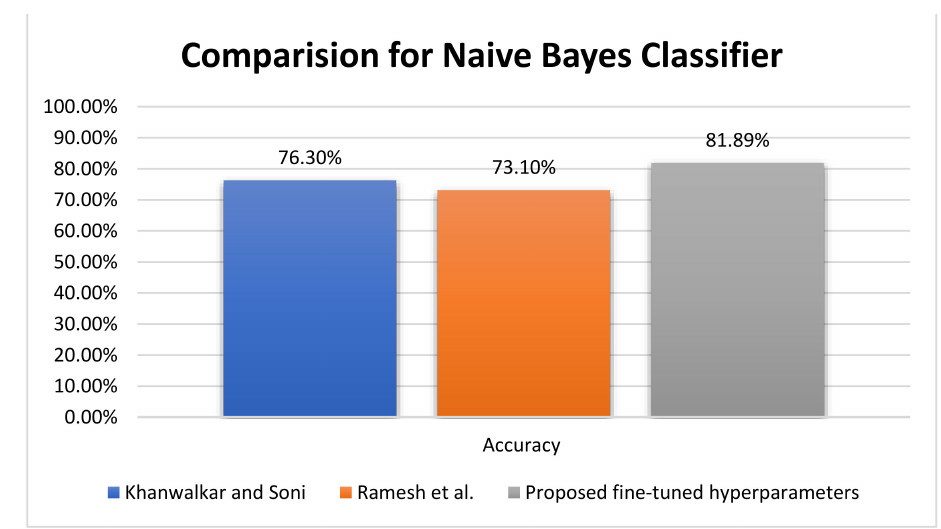
Figure 10. Comparative analysis of various configurations of NB using the